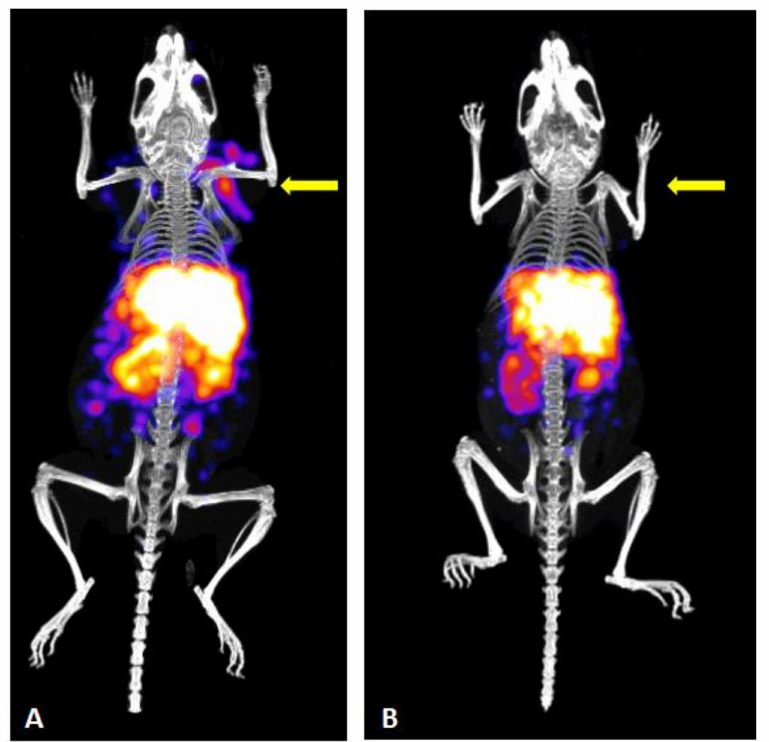
Figure 6. Representative SPECT/CT scans as MIP views of two A549 tumor-bearing mice injected with [ 111 In]-IP-001 ( A ), as well as [ 111 In]-IP-001 and 50-fold molar excess of unlabeled IP-001 (block- ing) ( B ) at 24 h post injection. Mice developing tumors approximately of the same size (about 112 mm 3 ) are shown. Tumor position in the shoulder is indicated by the